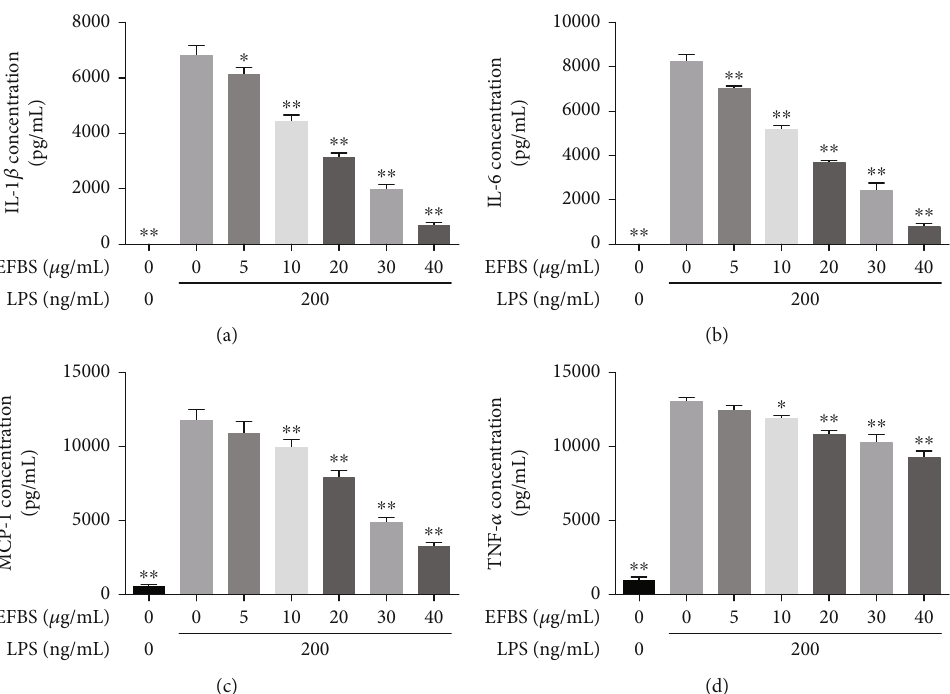
Figure 7: Proin fl ammatory cytokines level treated by di ff erent concentrations of EFBS. Statistical analysis was performed using one-way ANOVA followed by the Tukey-Kramer posttest. ∗ P < 0 : 05 , ∗∗ P < 0 : 01 compared with the LPS treatment